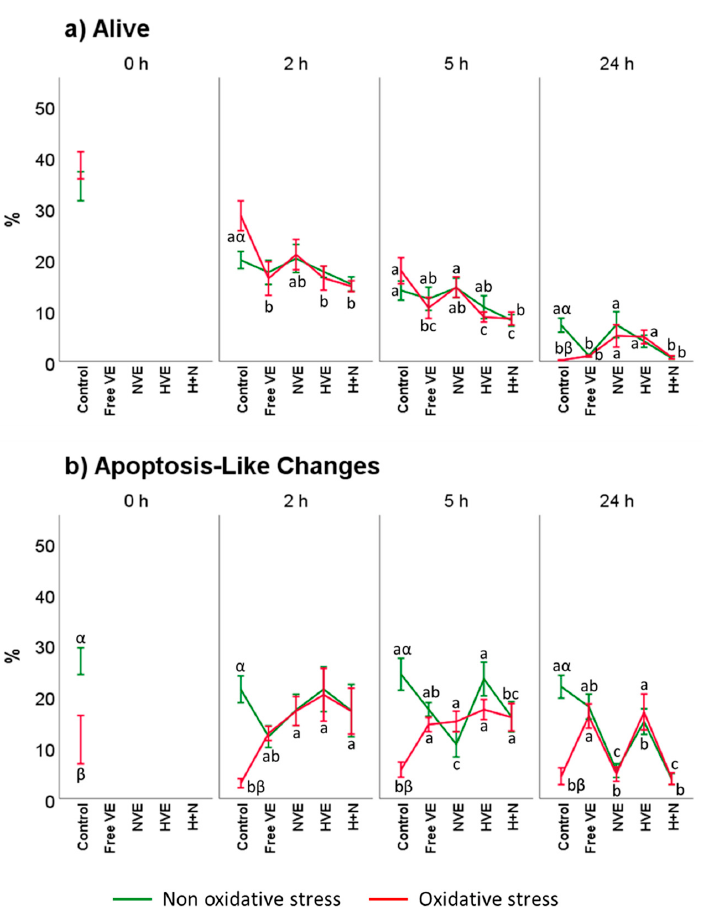
Figure 7. Vitamin E formulation effects on sperm viability. Plots ( a , b ) represent the triple interaction of different vitamin E treatments × oxidative treatment × incubation time for the flow cytometry analysis of sperm viability. The various lowercase Latin letters ( p < 0.05) indicate significant dif- ferences between vitamin E treatments, while the different Greek letters ( p < 0.05) compare each treatment at the same time with a different oxidative stress